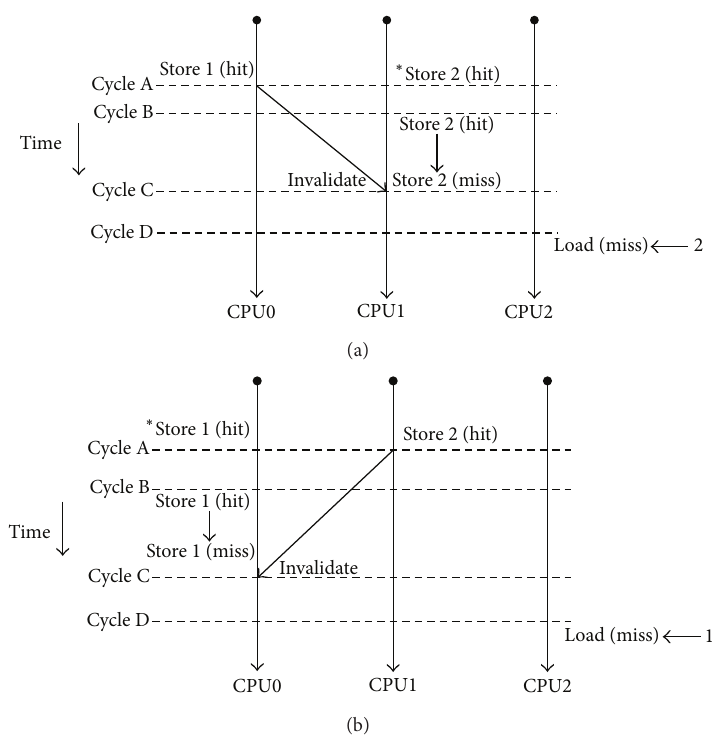
Figure 4: The execution result depends on the arbitration. (a) CPU0 executes before CPU1. (b) CPU1 executes before CPU0.